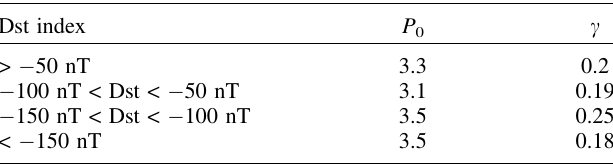
Table 3. Parameters which used for calculating the ring current injection rate, Q .